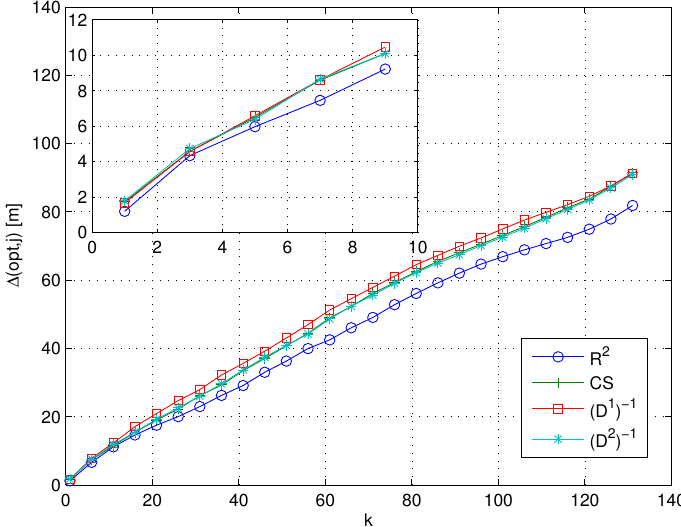
Figure 2. ∆ k ( ideal, j ) vs. k for different similarity